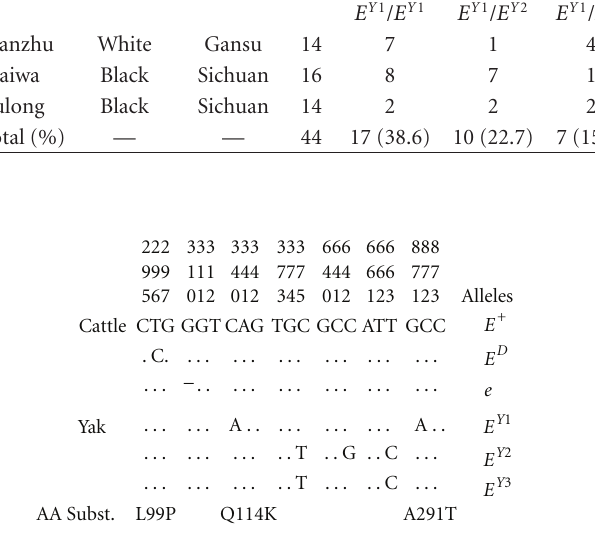
Table 1: Coat color and distribution of the MC1R haplotypes and genotypes in three Chinese yak breeds. Breeds Coat color Location No.